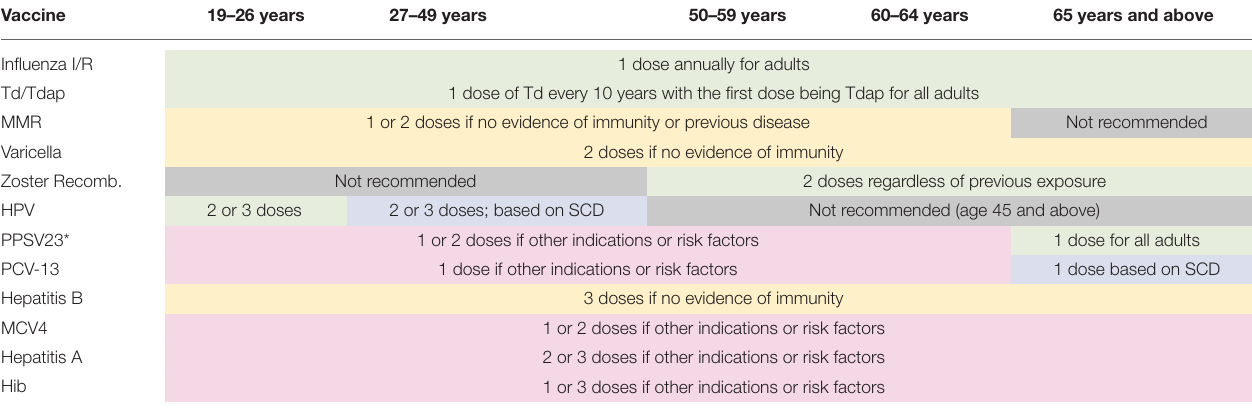
The table is color-coded according to five levels of recommendation: • Routinely indicated for all healthy adults.